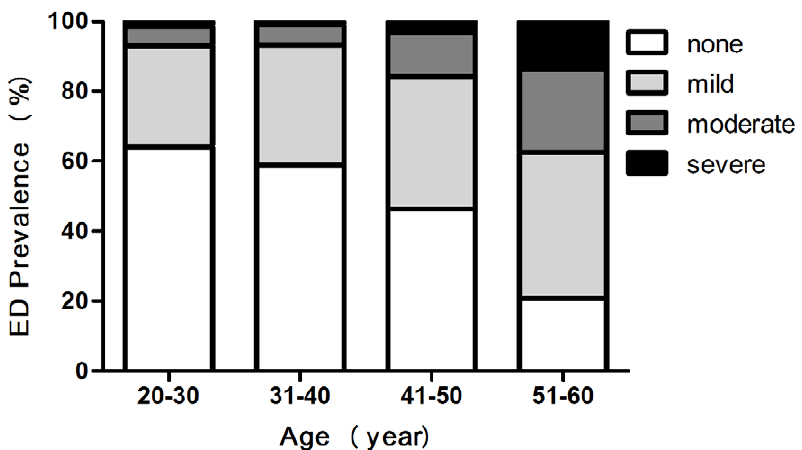
Figure 2. Prevalence of ED increases with age.